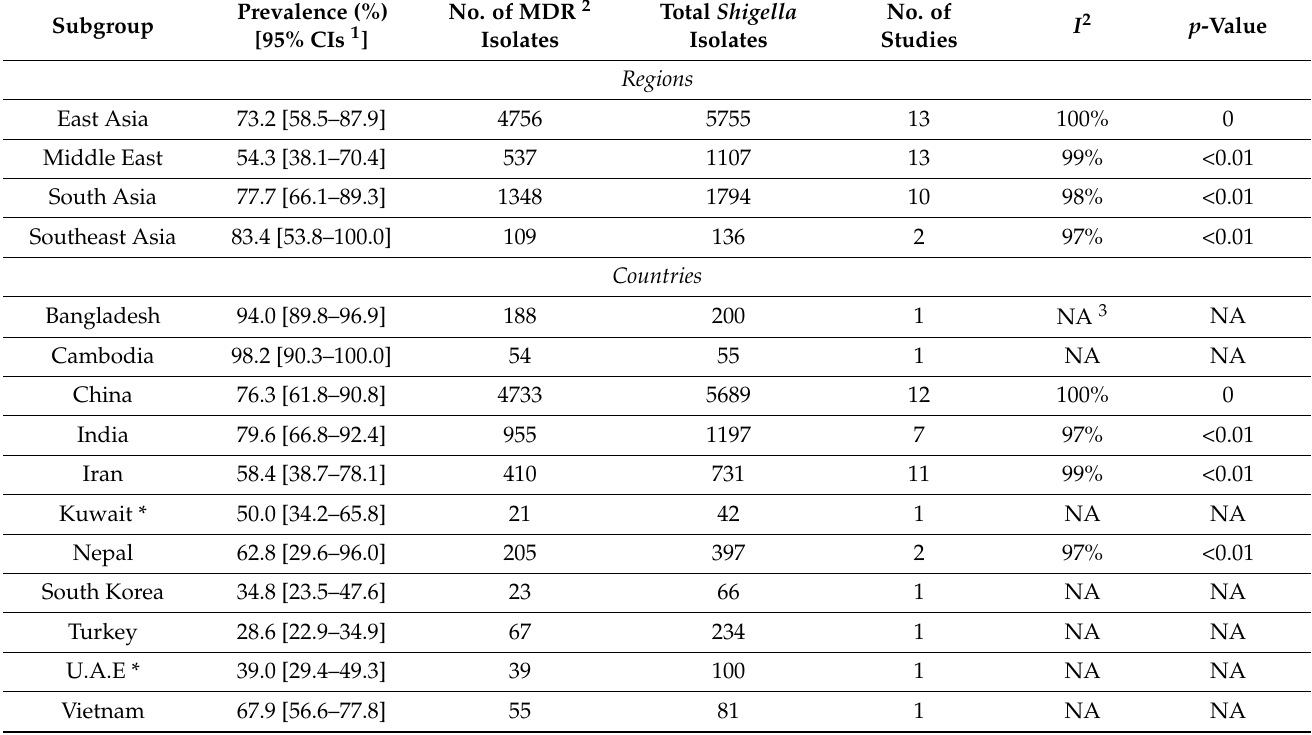
Table 4. Pooled prevalence of multidrug-resistant Shigella in different Asian regions.